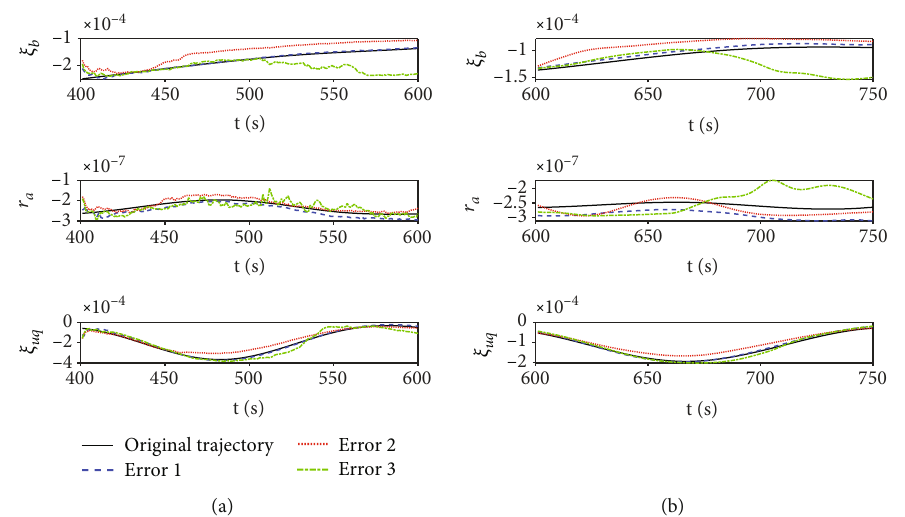
Figure 12: The variation of parameters with di ff erent error of observation. (a) is the variation of modi fi ed fi ltering maneuver parameters. (b) is the variation of predicted maneuver parameters.